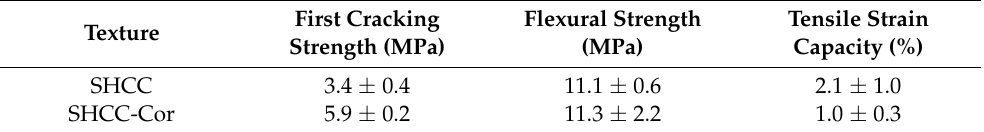
Table 3. Mechanical properties for SHCC and modified SHCC-Cor.